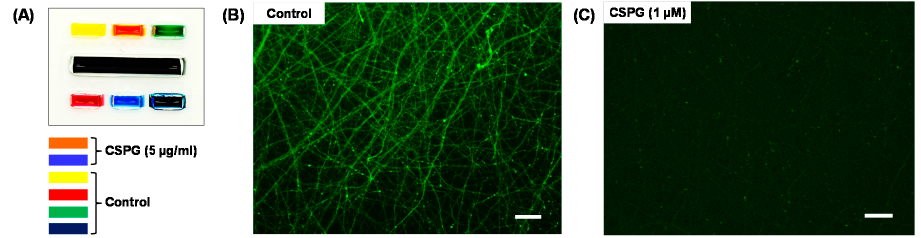
Figure 7. ( A ) Image of the high-throughput compartmentalized neuron culture platform with reservoirs filled with inks for visualization. Isolated axon ( B ) without the CSPG treatment (control) and ( C ) with the CSPG treatment inside the axon compartments. Cells were stained with Calcein-AM for visualization. Scale bars: 50 μ m.